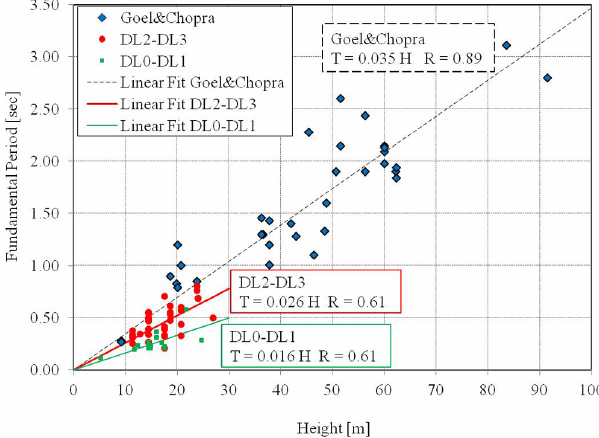
Fig. 8. Height vs. fundamental periods: comparison between 37 fun- damental periods estimated by Goel and Chopra (1997), and 64 in this study (considering only the damage levels lower that